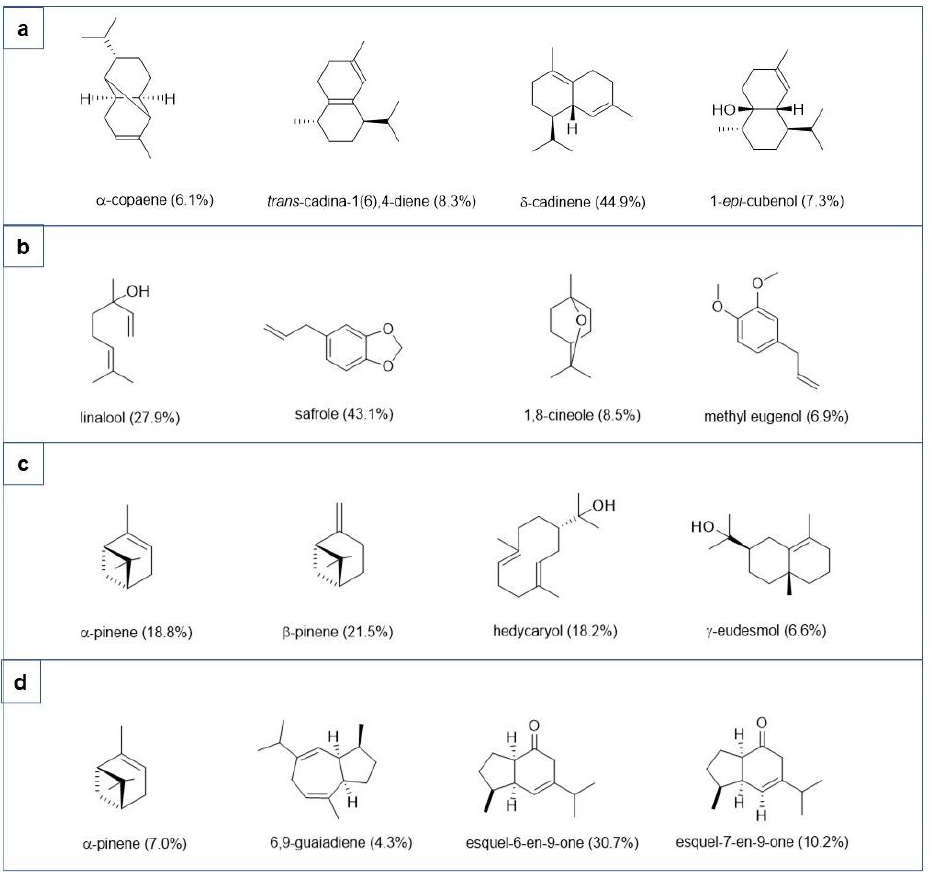
Figure 1. Main bioactive compounds of ciprés ( a ), tepa ( b ), canelo ( c ), and paramela ( d ) essential oils.